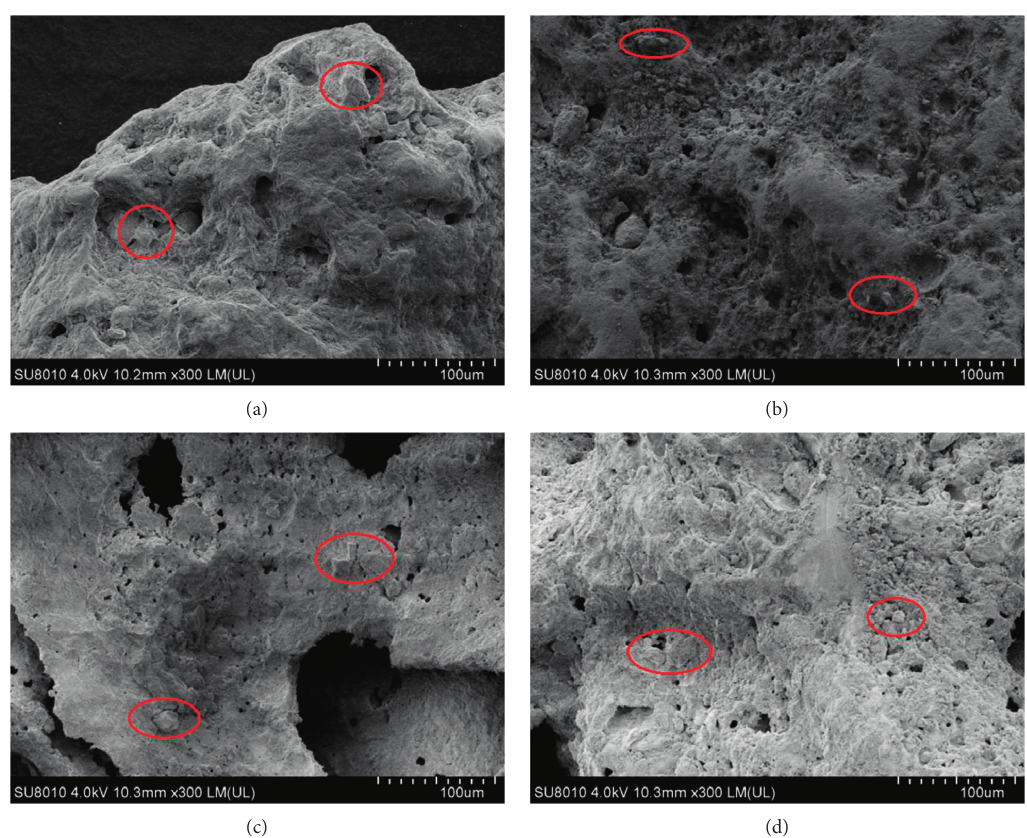
Figure 5: SEM images in a single grain size calcareous sand particle at an amplification factor of 300: (a) 1–0.5mm, (b) 2–1mm, (c) 3–2mm, and (d)